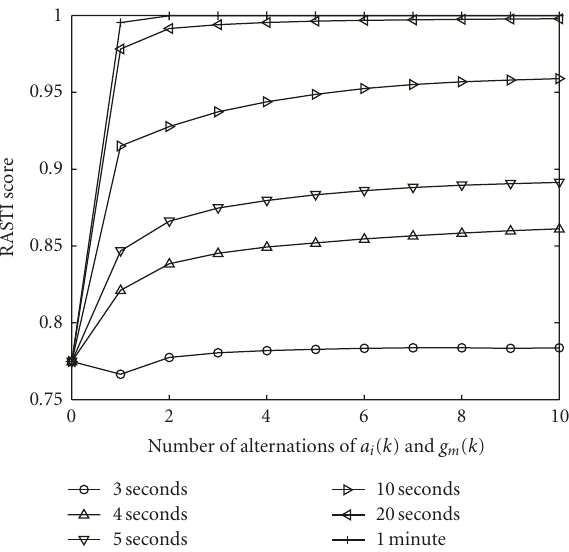
Figure 9: RASTI as a function of iteration